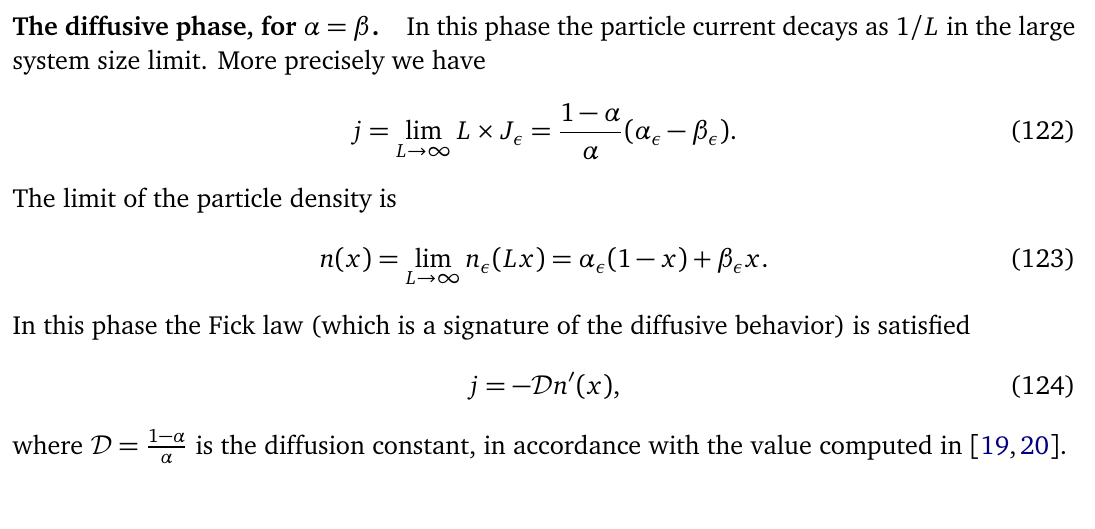
= 0.1, α = 0.5, β = 0.7, + − + = 0.7, α = 0.1, β = 0.3, + − +